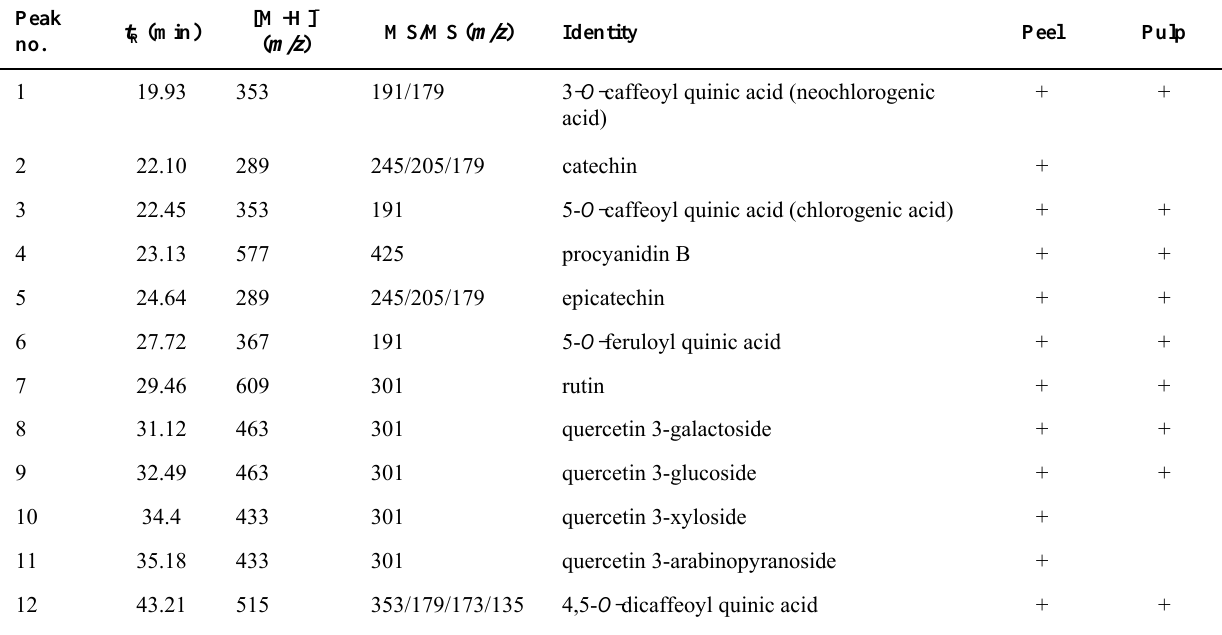
Table 2. Identification of polyphenols in Amazon grape peel and pulp.